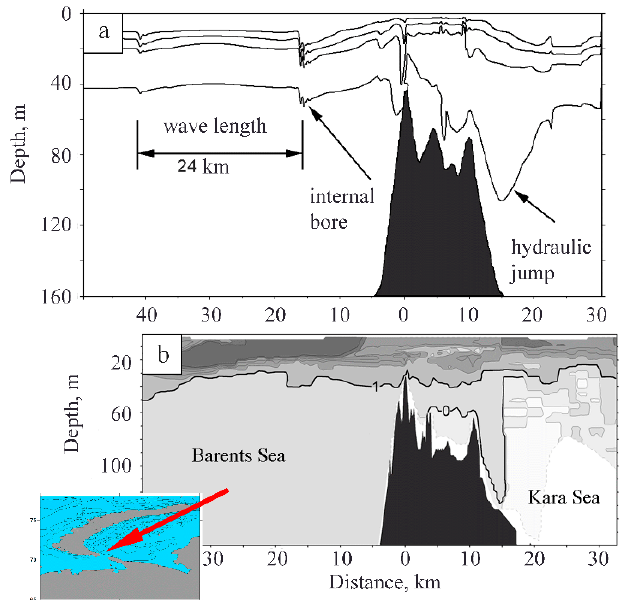
Figure 3. Field of isopycnals 23.5, 24.5, 25.5, and 26.5 perturbed by the flow in the Kara Gates Strait and internal waves based on numerical calculations using the model in [21,22]. The black color shows the bottom topography as specified in the model ( a ). Distribution of temperature over the towed section ( b ). Isotherms are shown with an interval of 1 ◦ C. Thicker lines show isotherms of 1 and 0 ◦ C to emphasize the observed effect. The black color shows the bottom profile. Location of the region on a larger scale is shown in the